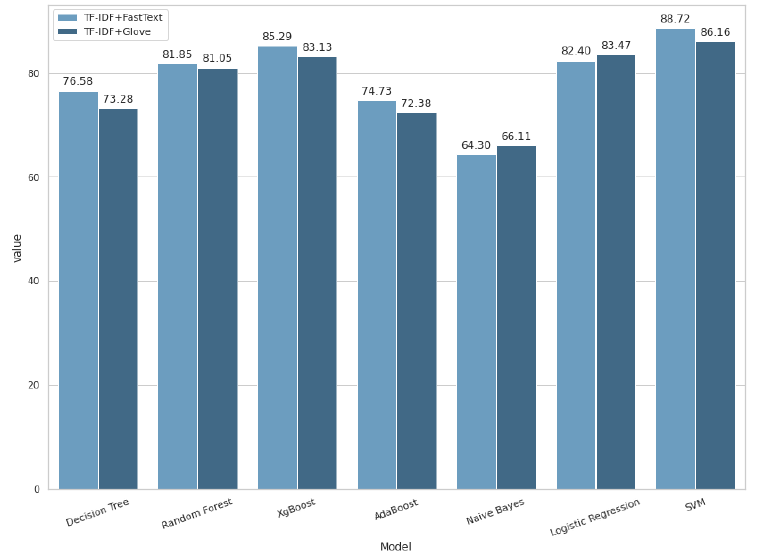
Figure 9. Visualisation of the accuracy of traditional classifiers for hybrid methods: TF-IDF with FastText and TF-IDF with Glove word embedding